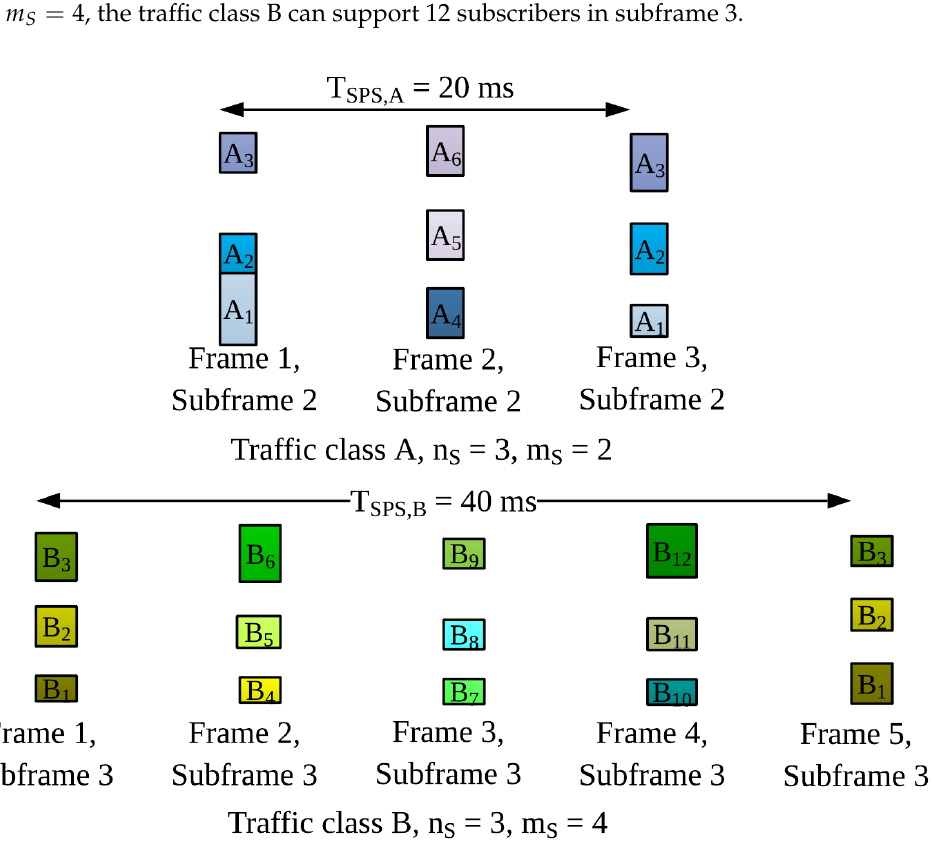
Figure 3. Time and frequency domain multiplexing for two example traffic